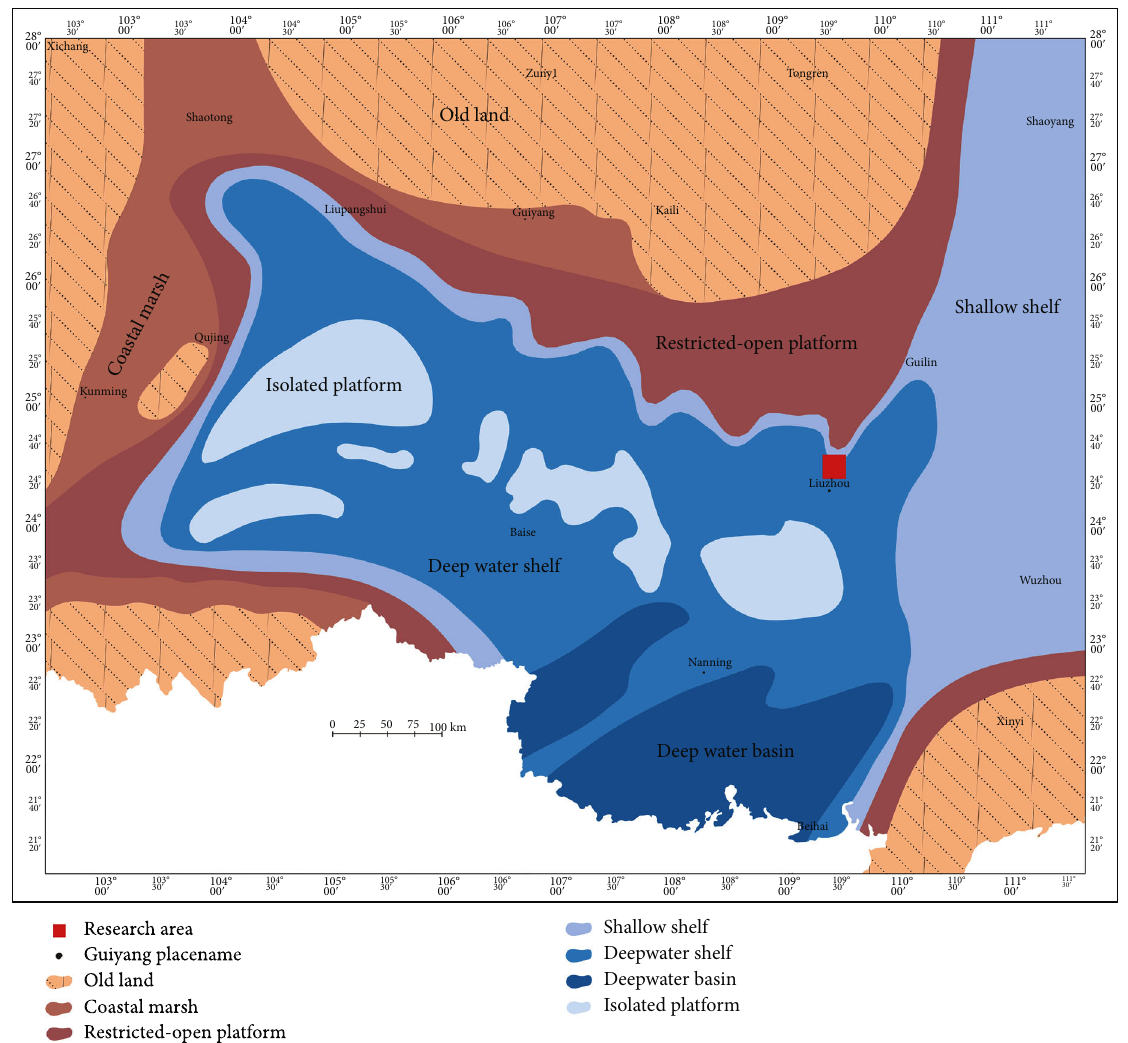
Figure 1: Early Carboniferous sedimentary paleogeographic map of Nanpanjiang area